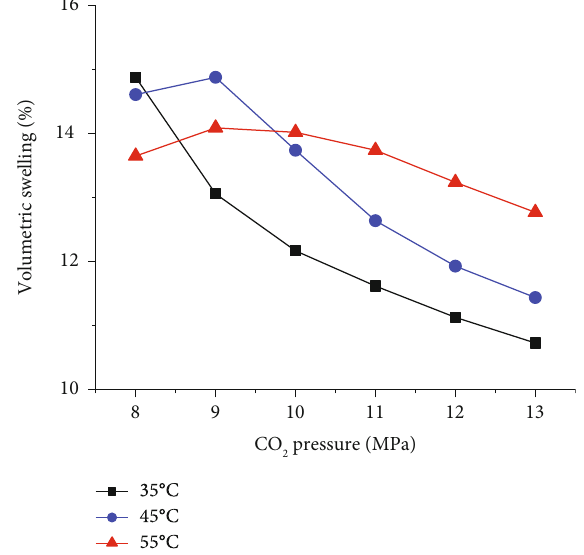
Figure 5: Volumetric swelling at di ff erent pressures and temperatures.